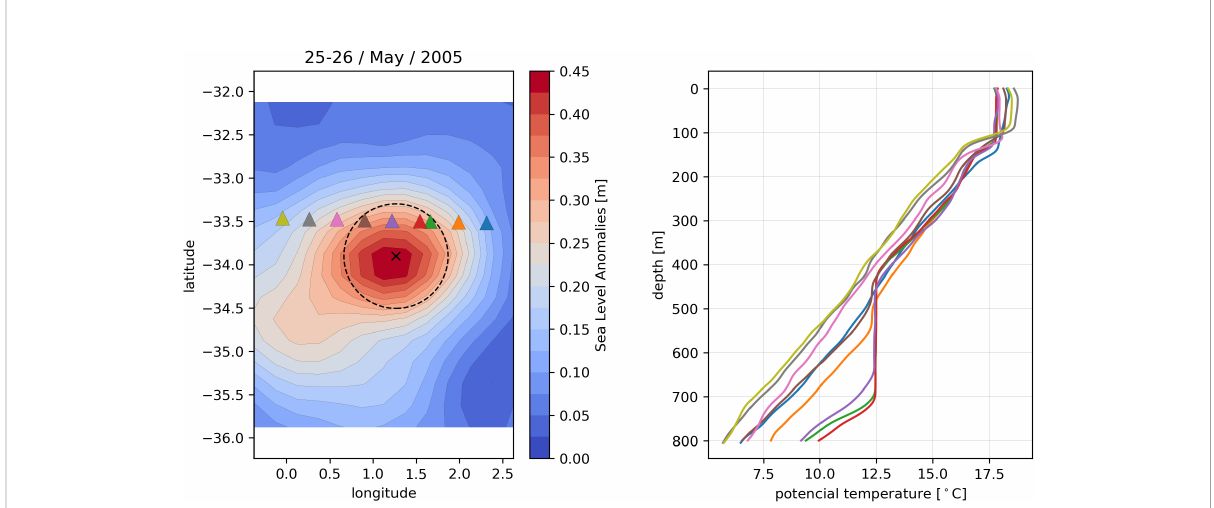
FIGURE 8 Left panel: Altimetry map showing the Ring Ana just before leaving Cape Basin and XBT launches in a section crossing it towards the west. The dashed circle marks the radius of the ring, estimated at 67 km. Right panel: Temperature pro fi les from the XBT section. The pro fi le colors identify the